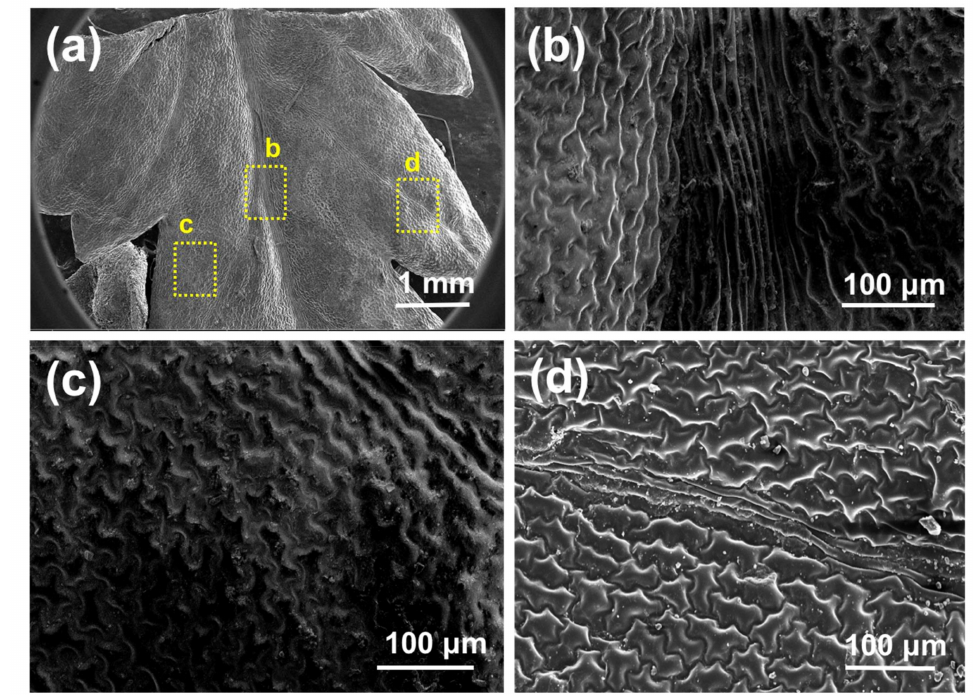
Figure 3. Scanning electron microscopy micrographs of a D. marginata leaf showing ( a ) the apex part of the pinnule, ( b ) the main channels, ( c ) the semicircular grooves and ( d ) the side channels.